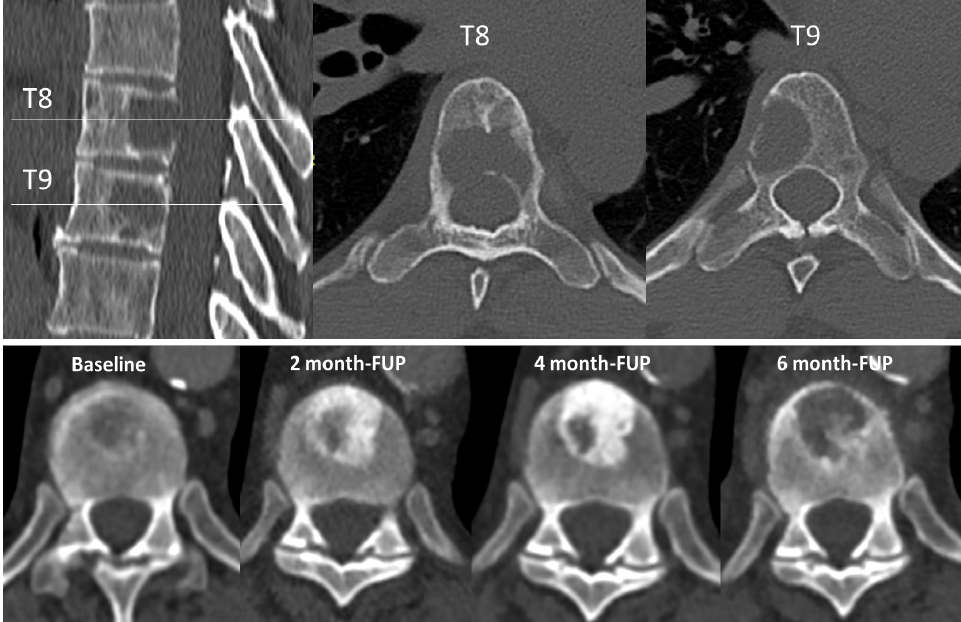
Figure 1. CT scan. Upper part: Multiplanar sagittal and axial reconstructions of the dorsal spine showing lytic lesions of myeloma involving T8 and T9 vertebrae. Lower part from left to right: progression of the size and condensation of a urothelial cancer bone metastasis under immunotherapy (avelumab), with initial lytic aspect and partial sclerosis of the lesion at 2 months. At 4 months, the sclerosis increases except in a focal region suspected of local progression. Confirmation of local progression with lysis of the sclerotic matrix at 6 months. FUP, follow-up.